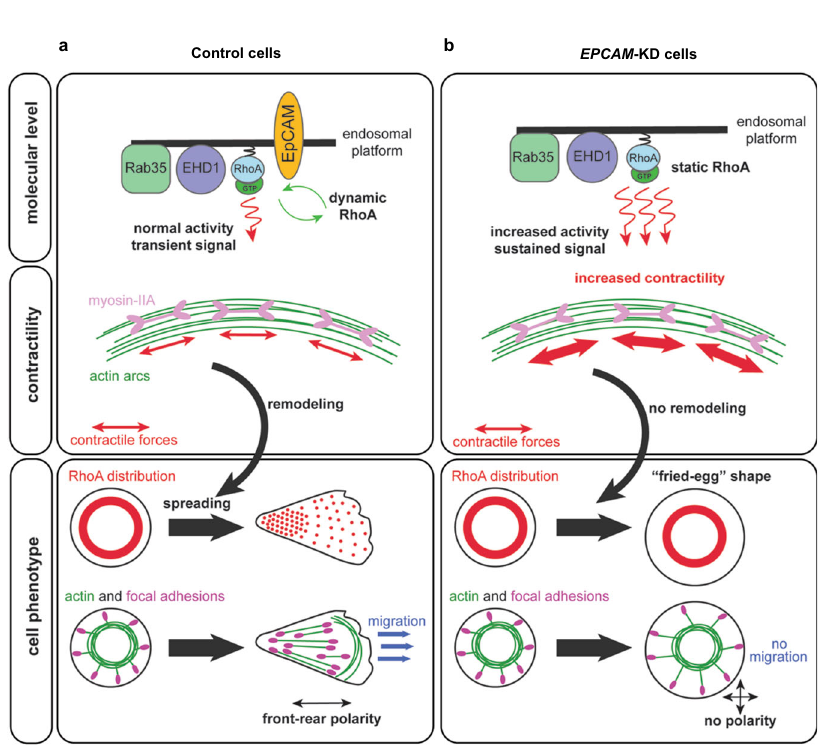
Fig. 9 Scheme depicting the proposed model of active RhoA dynamics in control and EPCAM -KD cells during spreading. a In control cells, active RhoA (RhoA-GTP) dynamics are promoted by EpCAM, to and from the Rab35 + /EHD1 + endosomal platform. The resulting transient signal induces normal myosin-II-dependent contractility at the level of the transverse arcs during spreading. At the cellular level, dynamic RhoA-GTP can be remodeled in a front – rear gradient as the cell spreads, participating to the acquisition of front – rear polarity. Correct contractility at the levels of the transverse arcs allows the formation of ventral stress fi bers and proper actomyosin cytoskeleton reorganization to promote epithelial cell migration. b In EPCAM -KD cells, active RhoA is blocked in the endosomal platform preventing the remodeling necessary for correct spreading, symmetry breaking, and polarity establishment. RhoA-sustained activity increases myosin-II contractility at the transverse arcs level, which hinders the formation of ventral stress fi bers. Active RhoA also increases formin activity, producing longer dorsal fi bers in EPCAM -KD cells. The absence of active RhoA and actomyosin cytoskeleton remodeling impedes symmetry breaking, giving EPCAM -KD cells a characteristic unpolarized fried-egg shape and preventing ef fi cient cell